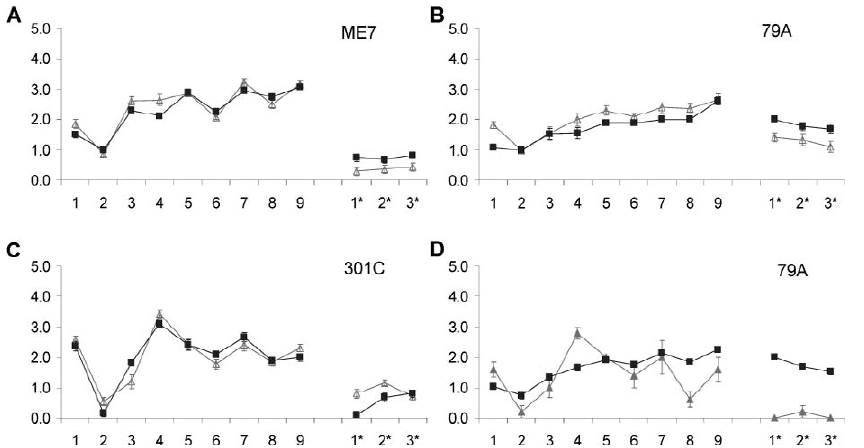
Figure 3. Lesion Profile Analysis of TSE-Inoculated PrP Glycosylation Mutant Mice G2 and 129/Ola mice were inoculated i.c. with TSE strains ME7 (A), 79A (B), or 301C (C) and G1 mice were inoculated i.c. with 79A (D). Squares: wild type; open triangles: G2; and solid triangles: G1. All mice (12 in each group) used in these analyses were clinically and pathologically positive. Nine gray matter areas: 1, dorsal medulla; 2, cerebellar cortex; 3, superior colliculus; 4, hypothalamus; 5, medial thalamus; 6, hippocampus; 7, septum; 8, cerebral cortex; 9, forebrain cortex and three white matter areas: 1*, cerebellar white matter; 2*, mesencephalic tegmentum; 3*, pyramidal tract ( x -axis) were scored on scales of 0–5 for gray and 0–3 for white matter areas ( y -axis). The mean scores for each area are shown (error bars 6 SEM). No differences between wild-type and G2 mice were observed after inoculation with ME7 (A) or 79A (B); however some differences in the superior colliculus and white matter areas were observed between the two groups when inoculated with 301C (C). Differences were observed between wild-type and G1 mice inoculated with 79A (D) especially in area: 2, 4, 8, and in the white matter.